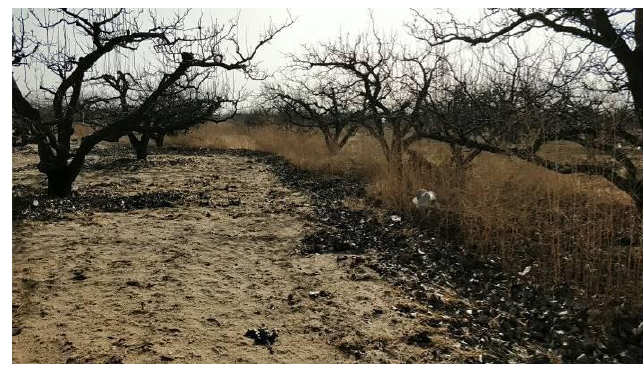
Figure 1. Layout of the research area.